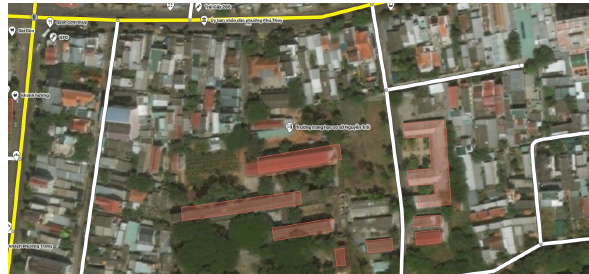
Figure 7. Low building completeness in Phan Thiet, Vietnam; but with a high share of building height attributes. Imagery: Bing (c)